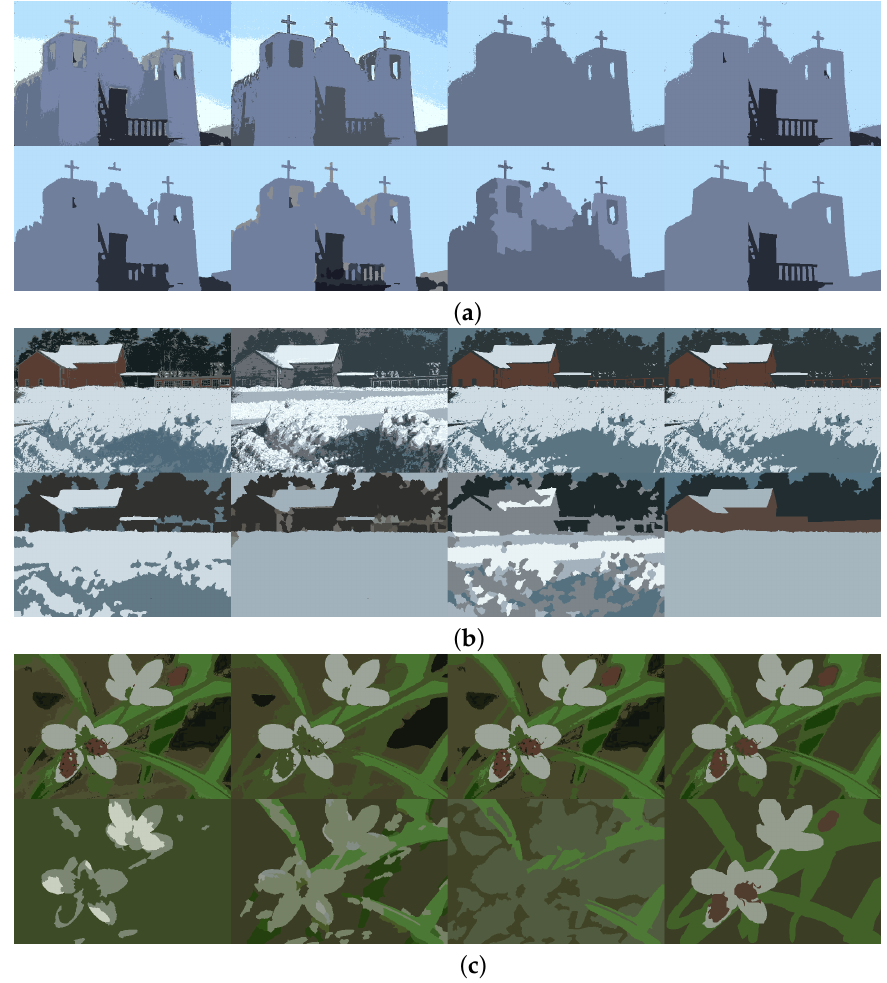
Figure 9. Segmentation results on different images from Berkley image segmentation dataset. First row: BIC, ICL, DEMP, and ENT algorithm. Second row: MS, DBSCAN, and OPTICS algorithm. Last image in second row is true segmentation. ( a ) Segmentation results of different algorithms on image 24063. ( b ) Segmentation results of different algorithms on image 97033. ( c ) Segmentation results of different algorithms on image